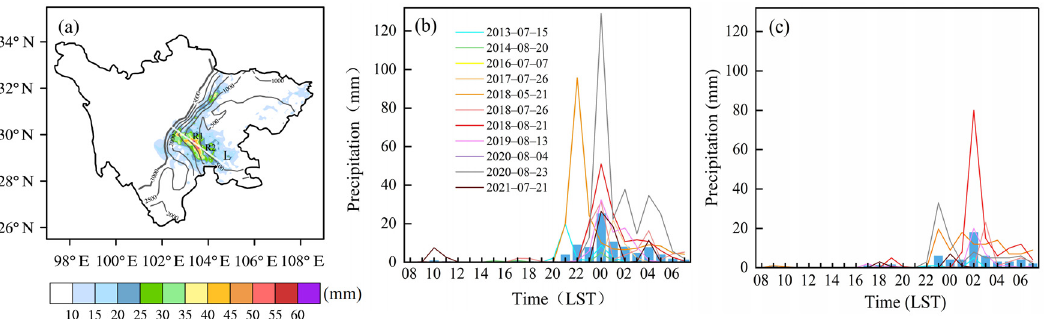
Figure 2. ( a ) Spatial distribution of accumulated precipitation at night and ( b , c ) diurnal variations of precipitation at station R1 (103.44° E, 29.73° N) and station R2 (103.44° E, 29.73° N). Line L cross R1 and R2. (Cases on 2 July 2010, 16 September 2010, 20 July 2011, and 26 July 2012 lack the precipitation data at station R1 and station R2).